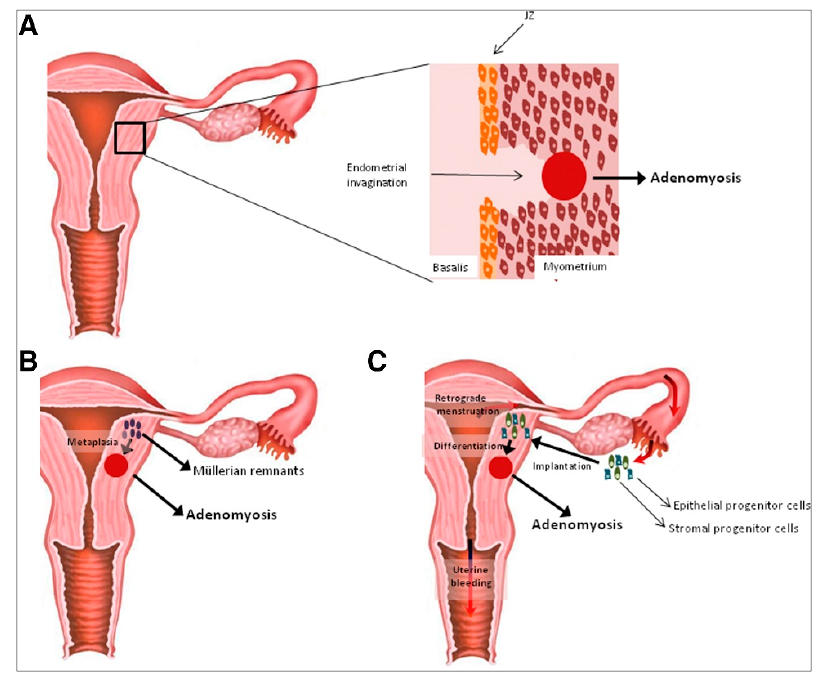
Figure 1. Hypotheses on the origin of uterine adenomyosis. ( A ) Invasion of the myometrium by endometrial tissue upon disruption of the JZ. ( B , C ) De novo generation of adenomyotic lesions as a result of ( B ) metaplasia of misplaced embryonic pluripotent remnants or ( C ) retrograde menstruation and subsequent implantation of endometrial progenitor cells in myometrial locations (reprinted with permission from [9]).